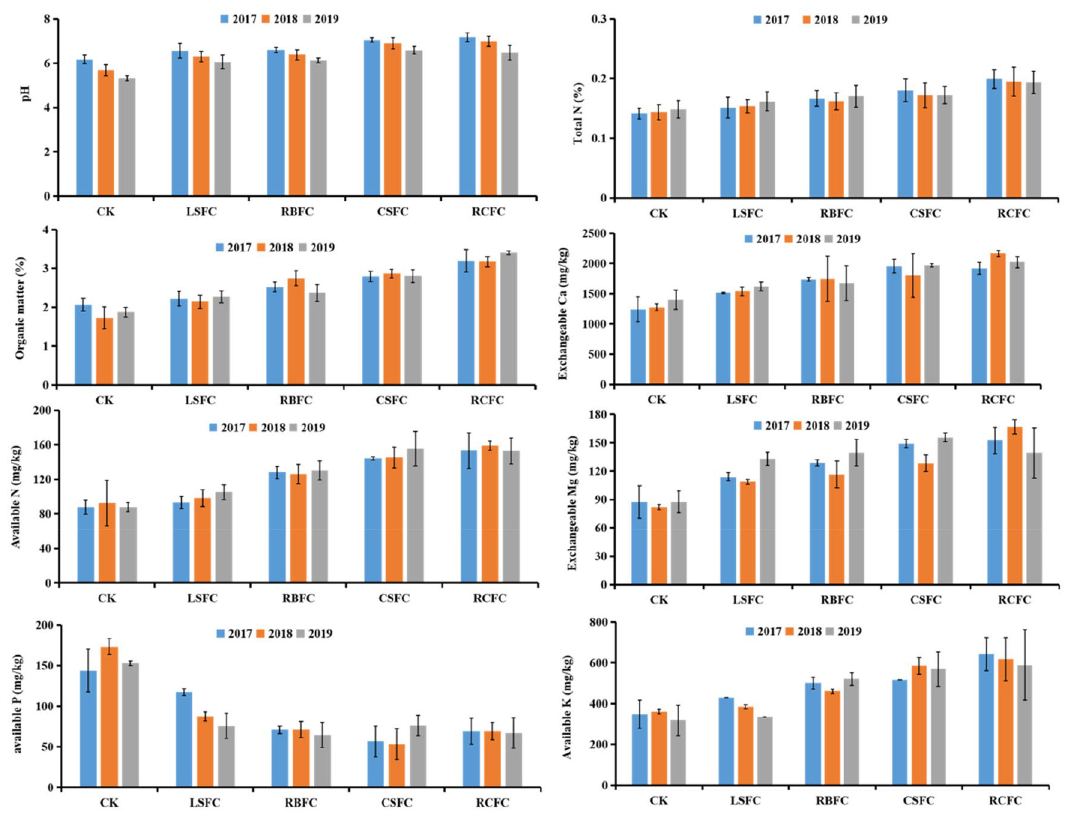
Figure 2. Soil physiochemical properties in different treatments from 2017 to 2019. Values are means of